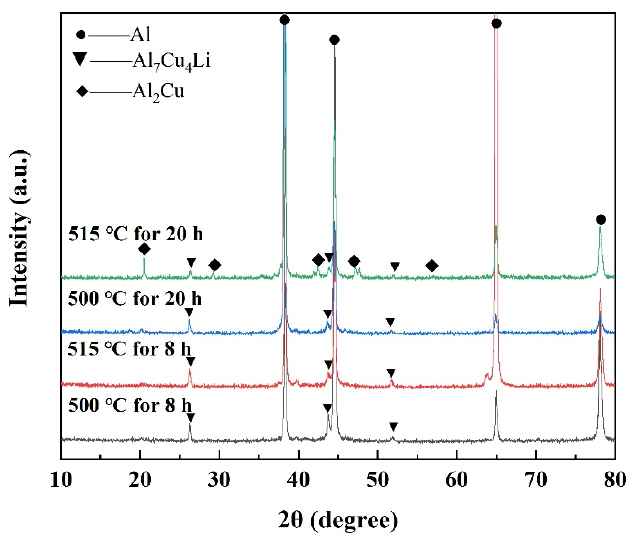
Figure 3. XRD (X-ray diffraction) patterns of the homogenized alloys. Table 1. Chemical composition of marked phases of homogenized alloys.